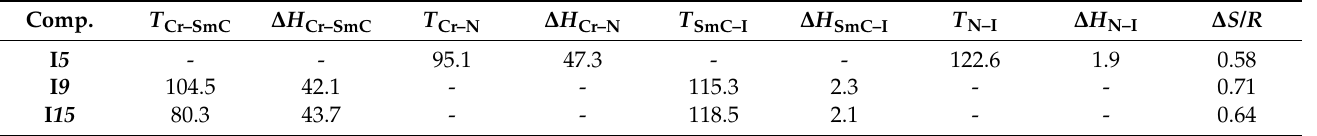
Table 1. Mesomorphic temperatures ( ◦ C), enthalpy ( ∆ H , kJ/mole), and entropy ( ∆ S /R) of transition for I n